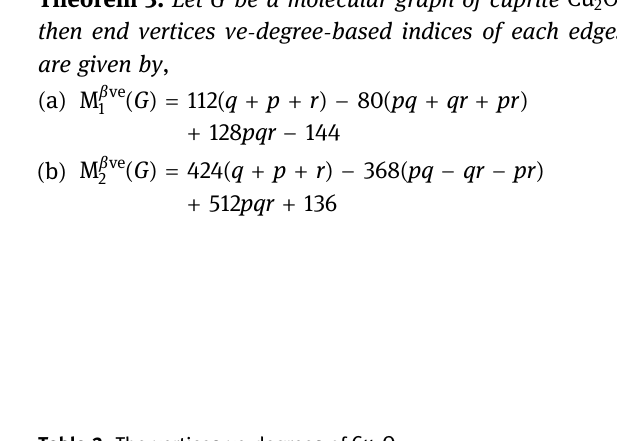
Table 2: The vertices ve - degrees of Cu O